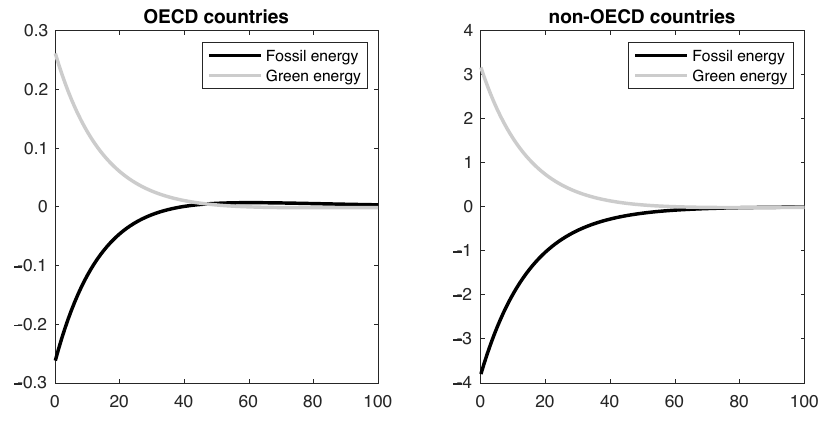
Figure 4. Control variables.